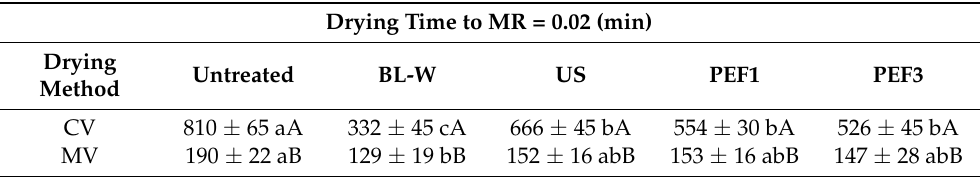
Table 1. Convective (CV) and microwave–convective (MV) drying time of red bell pepper (to moisture ratio MR = 0.02). Data are presented as a mean (from 2 repetitions) ± standard deviation. The different lowercase letters in row show different homogeneous groups, and different capital letters in columns show different homogeneous groups (Tukey’s HSD, α =